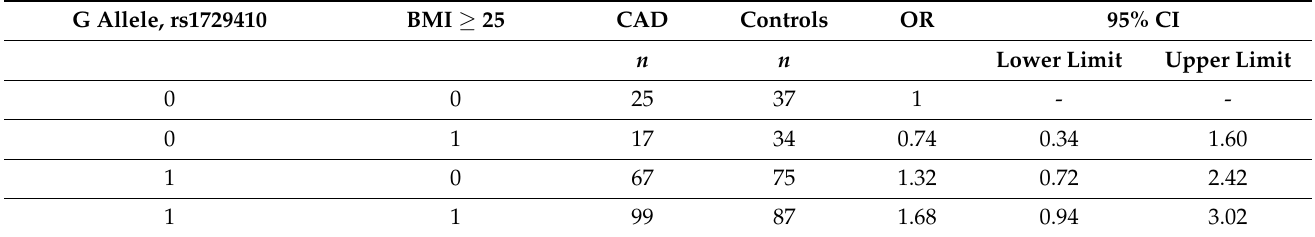
Table 5. Interaction analysis between carriers of the G allele of the rs1729410 polymorphism and over-normative BMI values.